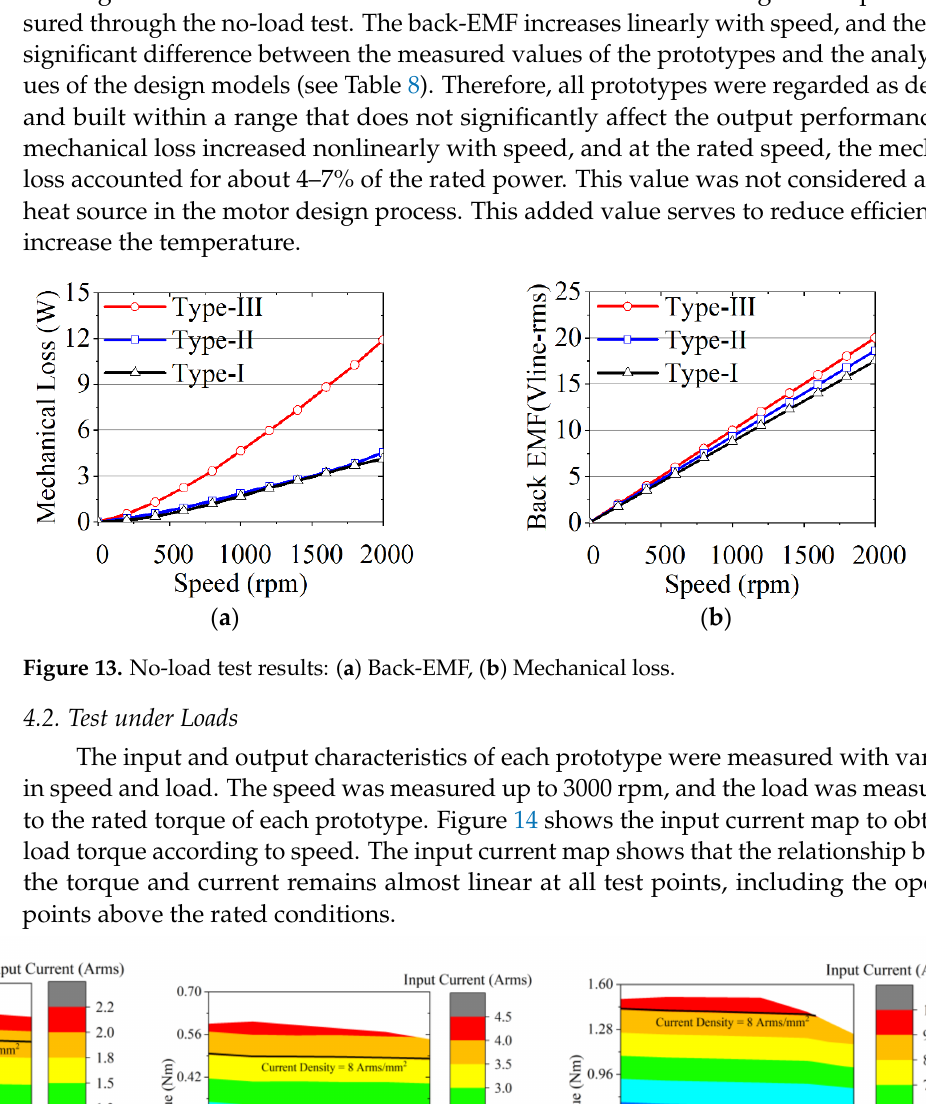
Fig. 11. Three types of joint motors and smart actuators. Figure 12. Three types of joint motors and smart actuators.